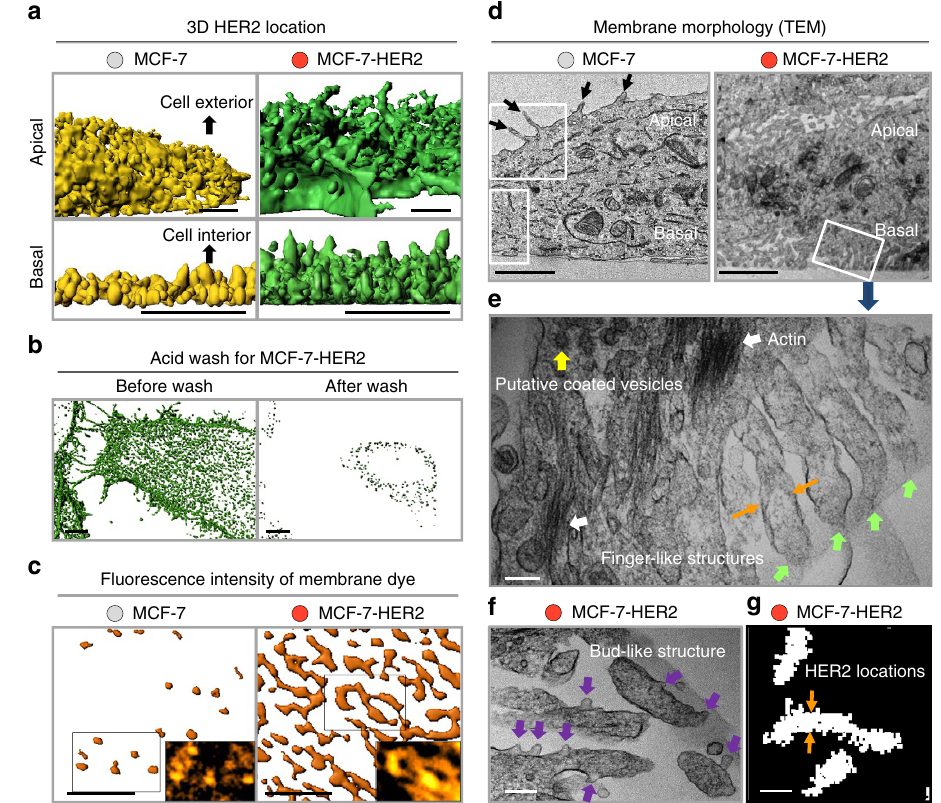
Figure 2 | Membrane deformation by high HER2 expression. ( a ) The 3D distributions of QD-labelled HER2s in the apical (top, side view) and basal membranes (bottom, side view) of MCF-7 (yellow) and MCF-7-HER2 (green) created from z-stack snap-shot fluorescence images using confocal microscopy (400ms bin time). In MCF-7-HER2, HER2s are broadly distributed along the z axis in elongated structures on both apical and basal sides, and the 2D projection of these morphologies appears as elongated clusters in the basal membrane as shown in b (before urea/acid wash). Scale bar, 3 m m. ( b ) The 2D projection of z-stack images of HER2 locations (green) from the basal membrane to B 3.3 m m inside of MCF-7-HER2 cells. Most of the a H2Fab:QD conjugates initially bound to HER2s (left) were removed by a 10min urea/acid wash (right). Scale bar, 3 m m. ( c ) High fluorescence intensity regions of the membranes stained with a lipophilic dye (orange) in live MCF-7 and MCF-7-HER2 cells. Inserts: raw fluorescence images inside the boxes. Scale bar, 4 m m. ( d ) TEM images of different cell membrane morphologies of MCF-7 and MCF-7-HER2. FLS of cell membranes are observed throughout the entire surface of MCF-7-HER2 cells. Zoomed-in images of MCF-7 inside white boxes are shown in Supplementary Fig. 3a. Scale bar, 2 m m. Panel e is the zoomed-in ( B 8 times larger) image of the region in the white box in d . Scale bar, 0.2 m m. ( f ) Bud-like membrane protrusions (violet arrows) are observed in MCF-7-HER2. Scale bar, 0.2 m m. ( g ) The width (the distance between two orange arrows) of the elongated clusters of HER2 locations (white dots) is B 0.18 m m ( n ¼ 200), which is similar to that of the FLS in e . The precision of determining the centre position 51 of a single QD is o 4nm, similar to the resolution of the EM. Scale bar, 0.2 m